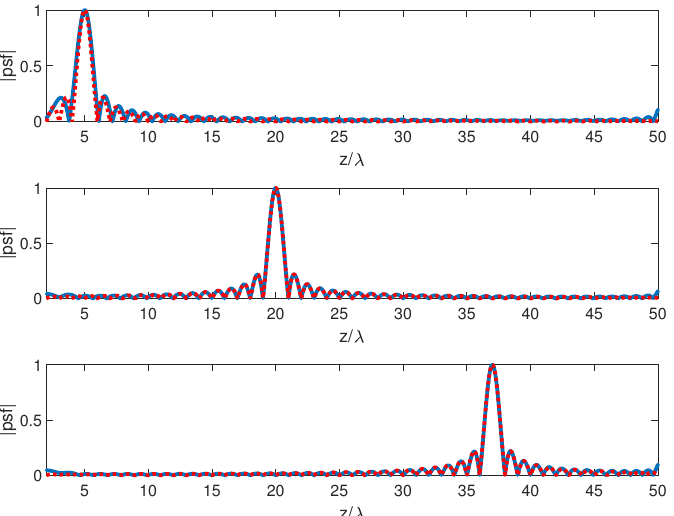
Figure 6. Magnitude of the point spread function for a = 15 × 10 3 λ , z 1 = 2 λ and z 2 = 50 λ . The blue line is psf , while the dotted red line refers to psf h . In top panel z (cid:48) is 5 λ , in the middle 20 λ and in the bottom 37 λ